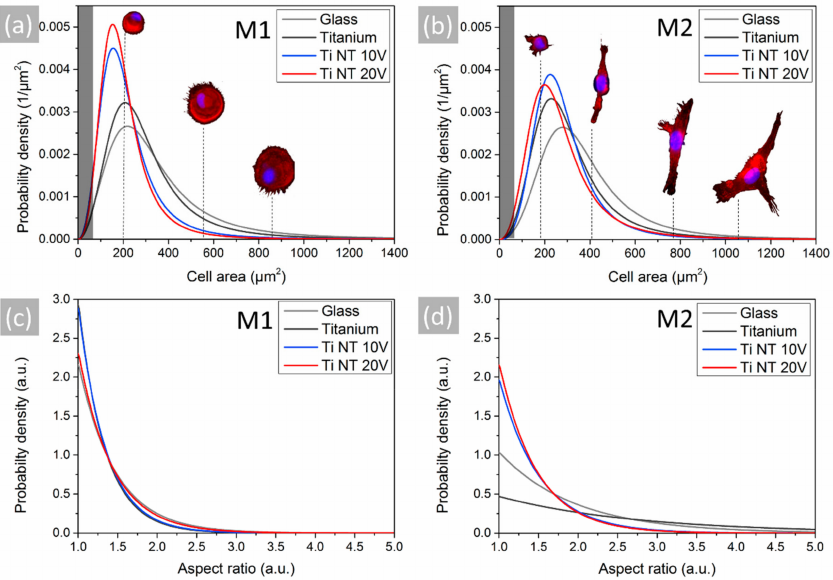
Figure 5. Statistical analysis of cell morphology. Probability density of ( a , b ) cell area and ( c , d ) aspect ratio for the M1- and M2-polarized macrophages on glass, Ti and the Ti nanotubes (NT) surfaces obtained from fluorescence microscopy images. Data were merged for all five donors. Images of cells typically found at a size indicated by the dashed lines are inserted into the graphs to facilitate conceivability. The darkened parts in graph ( a , b ) indicate the range of cell size where no cells could be